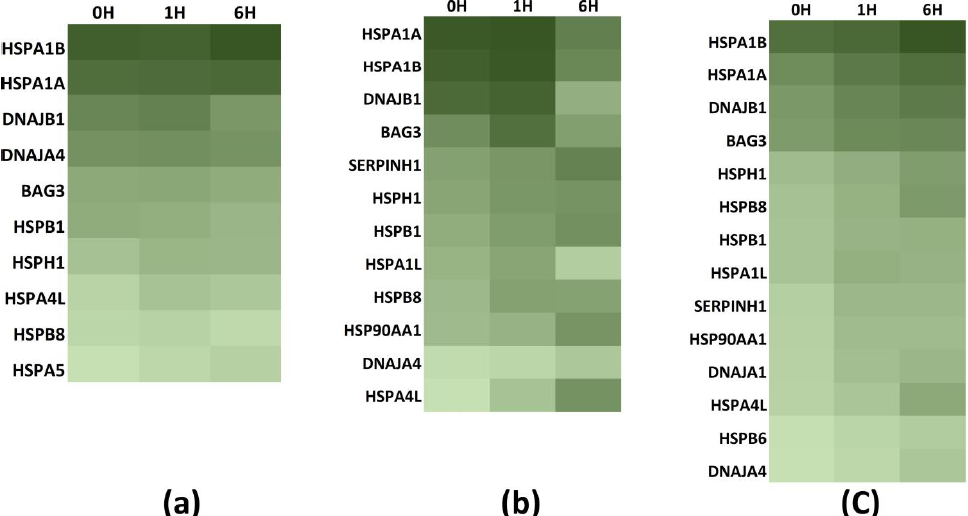
Figure 4. Heat maps showing the temporal expression of statistically significant ( p < 0.05) expressed genes at the completion of heat stress (0 h) and during recovery at 37 °C at 1 h (1 h) and 6 h. The maximal time point for gene expression at 0 – 1 h in ( a ) Daoy, ( b ) SH-SY5Y, and 6 h in ( c ) differentiated SH-SY5Y. In all three cell types, significantly high expression of HSPA1A , HSPA1B , DNAJB1 , and BAG3 at 0 h is visible.